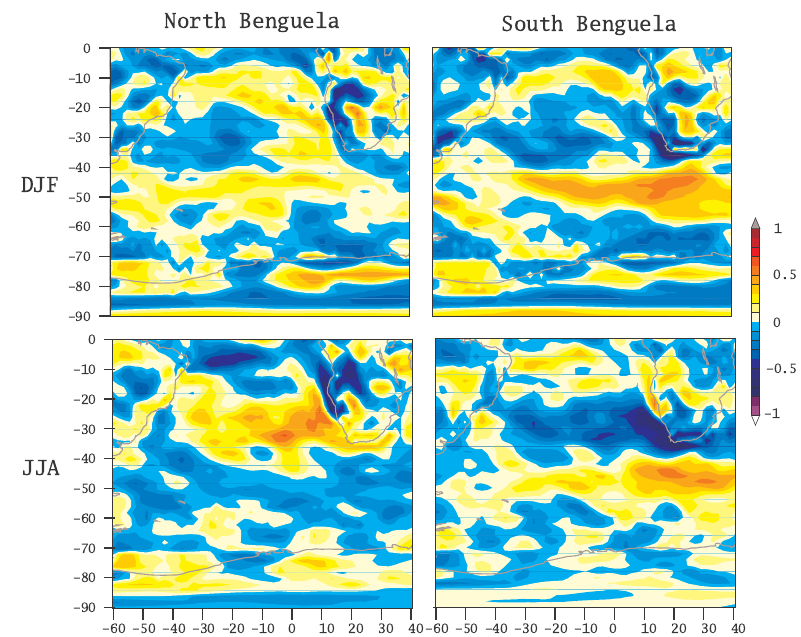
Figure 10. Correlation patterns between the simulated upwelling indices and the NCEP/NCAR reanalysis wind stress curl for North and South Benguela and for DJF and JJA in the period